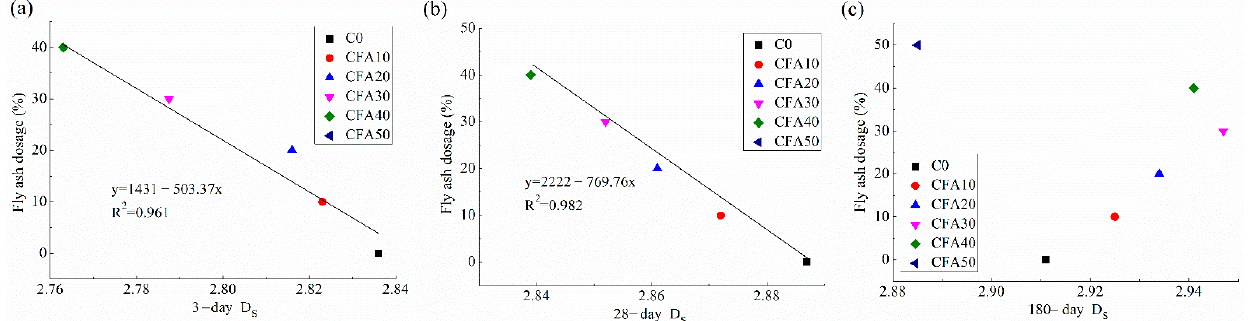
Figure 3. The relationship between the fly ash dosages and ( a ) 3-day D s , ( b ) 28-day D s and ( c ) 180- day D s